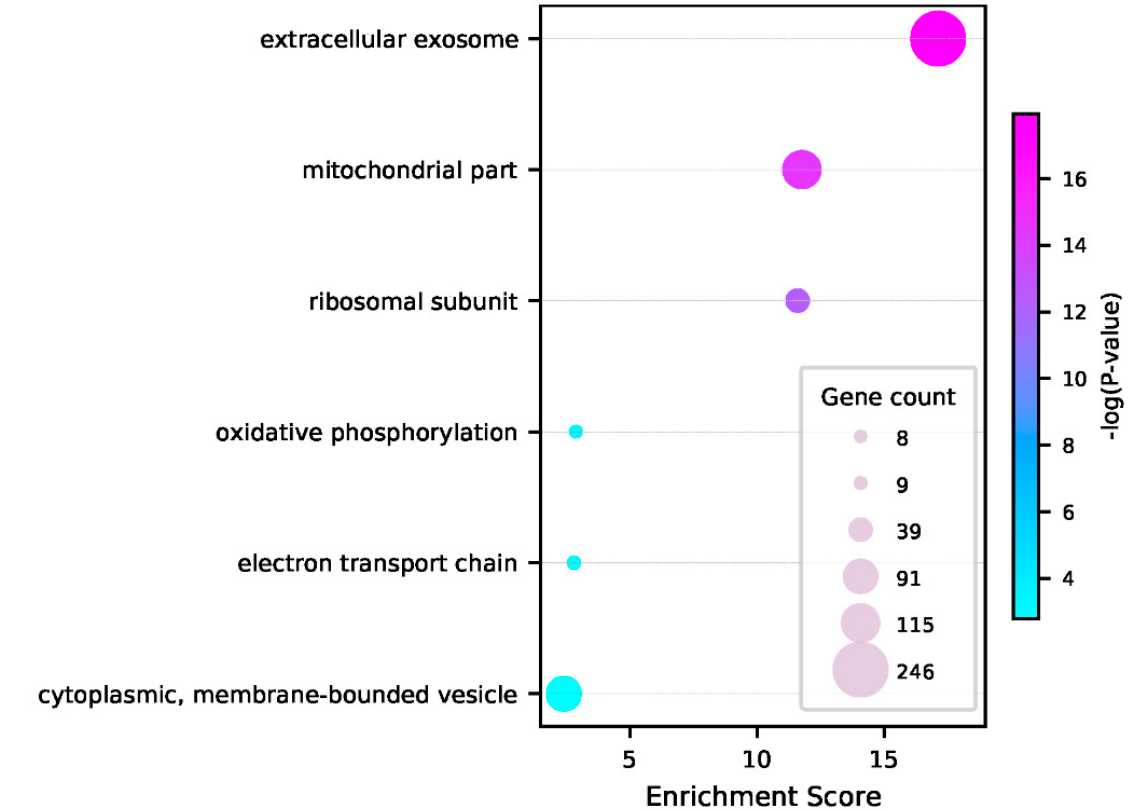
Figure 5. Functional terms enriched within the high-confidence candidate RNAs. The DAVID functional annotation clustering analysis was performed for the list of 1400 high-confidence candidate RNAs predicted by PredSynRNA to be synaptically localized. GO terms (GOTERM_BP_4, GOTERM_CC_4, and GOTERM_MF_4) were used for the functional analysis. For each annotation cluster, the most enriched GO term, its gene count, and statistical significance are shown in the diagram.